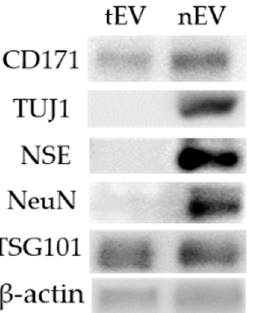
Figure 6. Characterization of neuronal exosomes (nEVs) isolated from mouse serum. Western blot data demonstrating the enrichment of nEV-associated markers. nEV marker; CD171. Neuronal markers; neuron-specific class Ⅲ beta-tubulin (TUJ1), neuron-specific enolase (NSE), and neuronal nuclei (NeuN). Exosome marker; tumor susceptibility gene 101 (TSG101). Western blot was performed in triplicate.